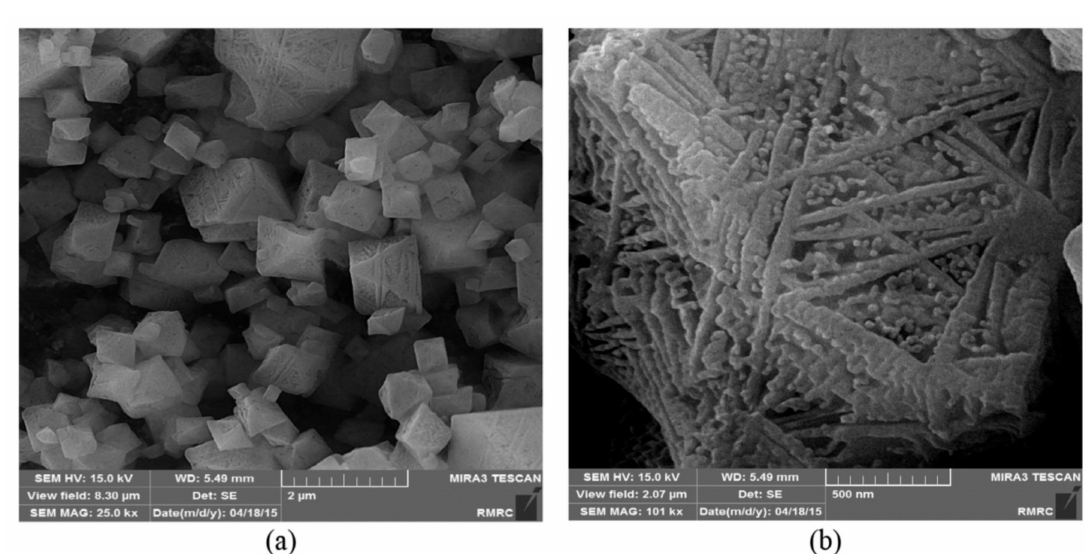
Figure 22. FESEM micrographs of HKUST-1 in different scales: ( a ) 2 µ m, ( b ) 500 µ m. Reprinted with permission from Ref. [161]. Copyright 2019 Elsevier.